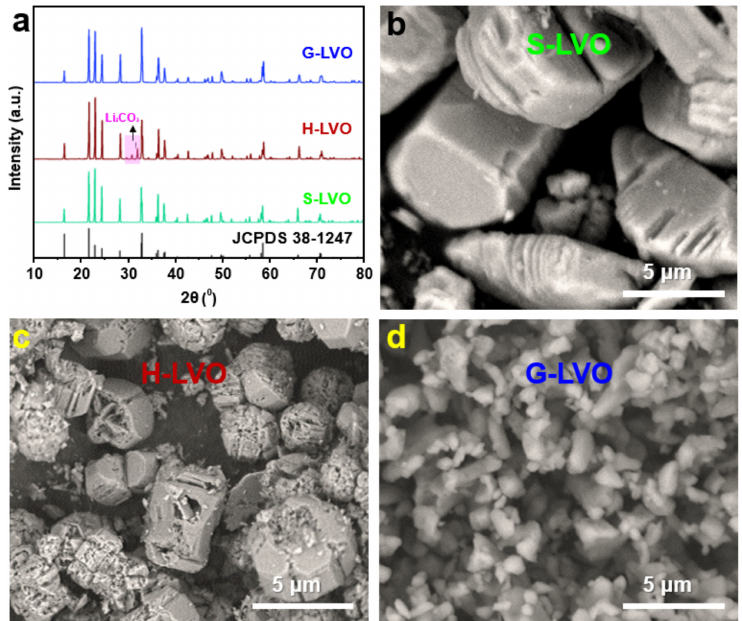
Figure 2. ( a ) XRD patterns of G-LVO, H-LVO, and S-LVO. ( b ) SEM image of S-LVO. ( c ) SEM image of H-LVO. ( d ) SEM image of